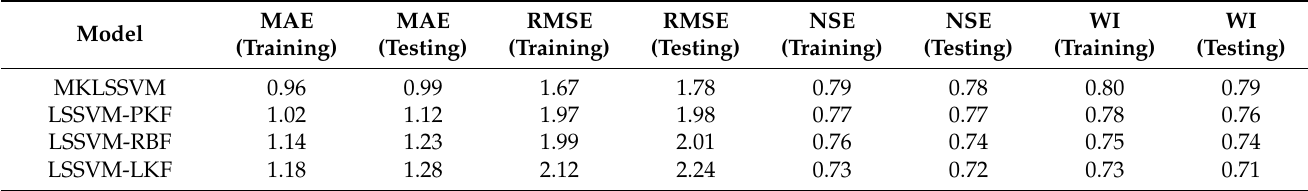
Table 3. Investigation of the accuracy of the LSSVM models.